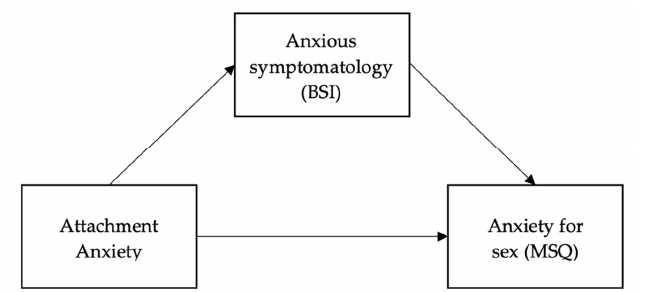
Figure 1. Hypothesis 2 mediation model.